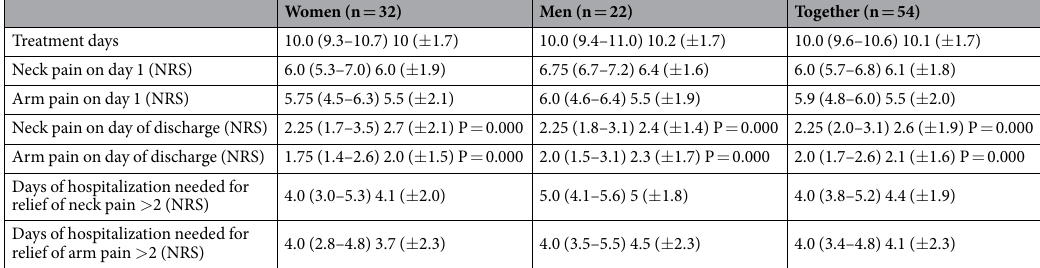
Table 3. Data on pain treatment of the patient group (median and interquartile range; mean and standard deviation).